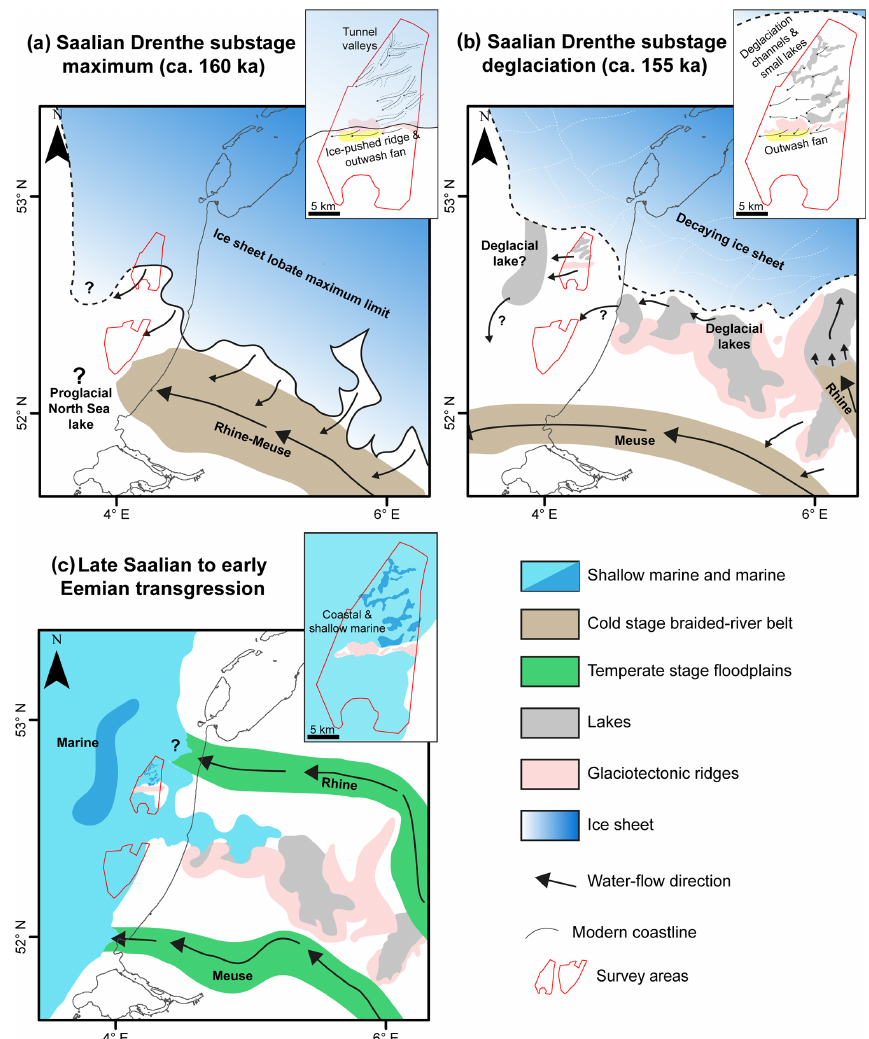
Figure 9. Palaeogeographic maps depicting the landscape evolution in the study area. Inset maps show the detailed evolution reconstructed at the Hollandse Kust Noord (HKN) wind-farm site. (a) Palaeogeography during maximum ice sheet extent in the Saalian Drenthe substage ca. 160ka (Busschers et al., 2008; Toucanne et al., 2009). Ice advancing into HKN deformed the underlying strata and carved subglacial meltwater channels. An E–W-oriented glaciotectonic ridge indicates the position of the maximum ice front. A contemporary proglacial lake has been proposed in earlier work (Busschers et al., 2008; Hijma et al., 2012), but no evidence or confirmation has been found in this study. (b) Saalian Drenthe substage deglaciation ca. 155ka (Busschers et al., 2008; Toucanne et al., 2009). Overspilling, interconnected lakes of varied dimensions occupied the deglaciated tongue basins (Beets et al., 2006; Busschers et al., 2008; Laban, 1995; van Leeuwen et al., 2000; Zagwijn, 1996, 1983), as well as smaller-scale subglacial channels. The Rhine River diverted into a larger basin in the east of the depicted area. Drainage in the HKN study area was mainly directed to the larger “P/Q” tongue basin lake in the west. (c) Latest Saalian to early Eemian North Sea transgression phase, depicted for a sea-level elevation of 30m below present-day level. Coastal to marine transgressive deposits buried the Saalian glacial landscape in the study area (Peeters et al., 2016, 2015; van Leeuwen et al., 2000; Zagwijn, 1983). The distribution of these deposits and the timing of the flooding are conditioned by the antecedent topography inherited from the late Saalian